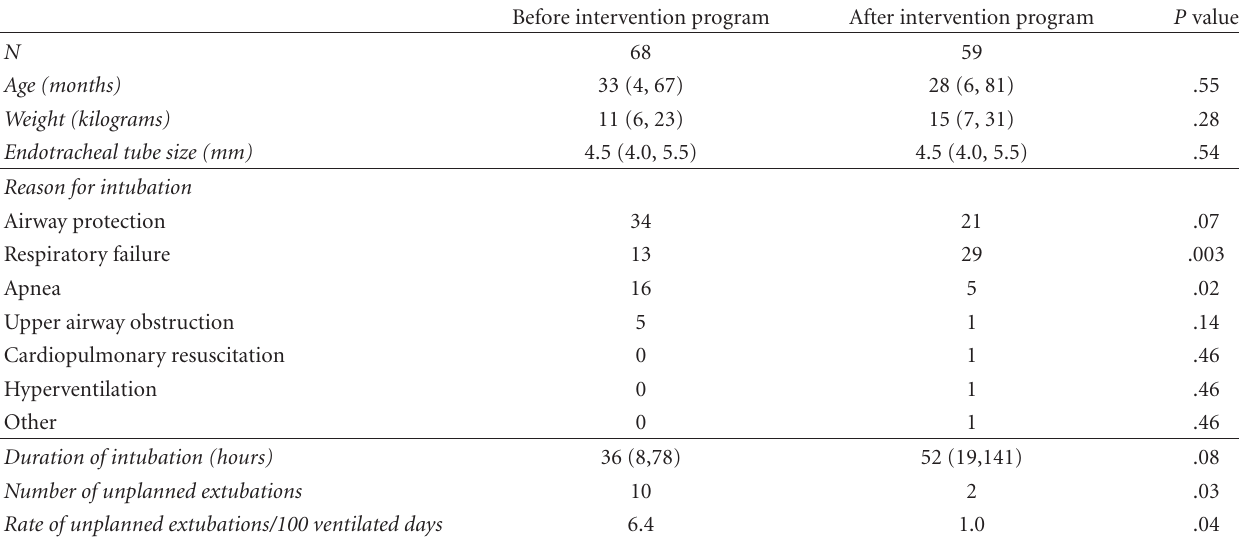
Table 1: Clinical features of intubated children before and after the intervention program. Before intervention